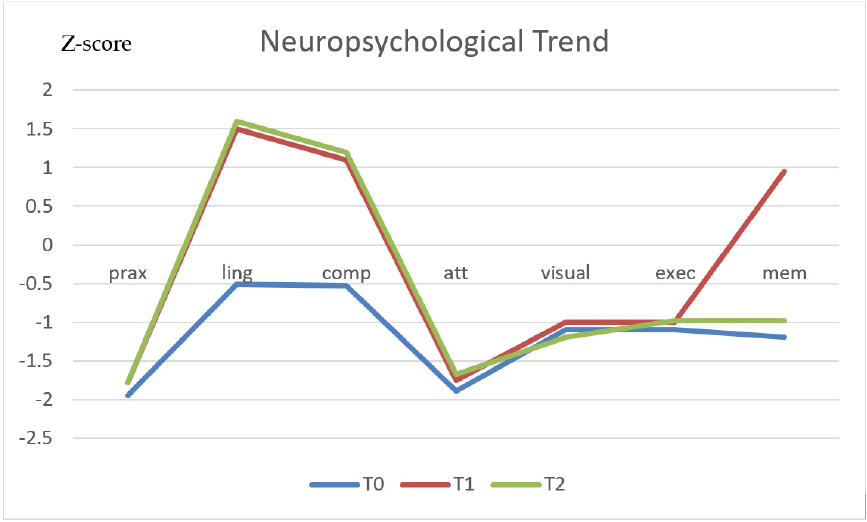
Figure 1. Neuropsychological functions.